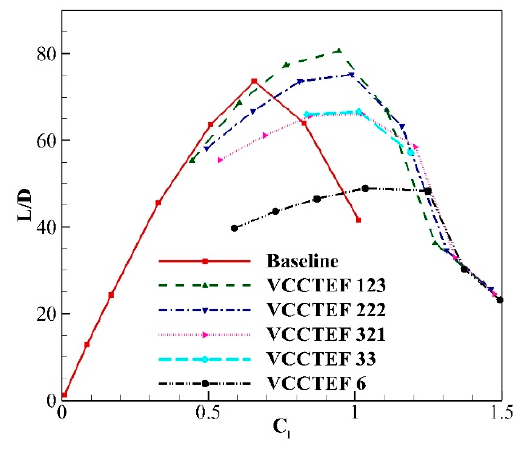
Figure 26. Variation of lift to drag ratio with the coefficient of lift.